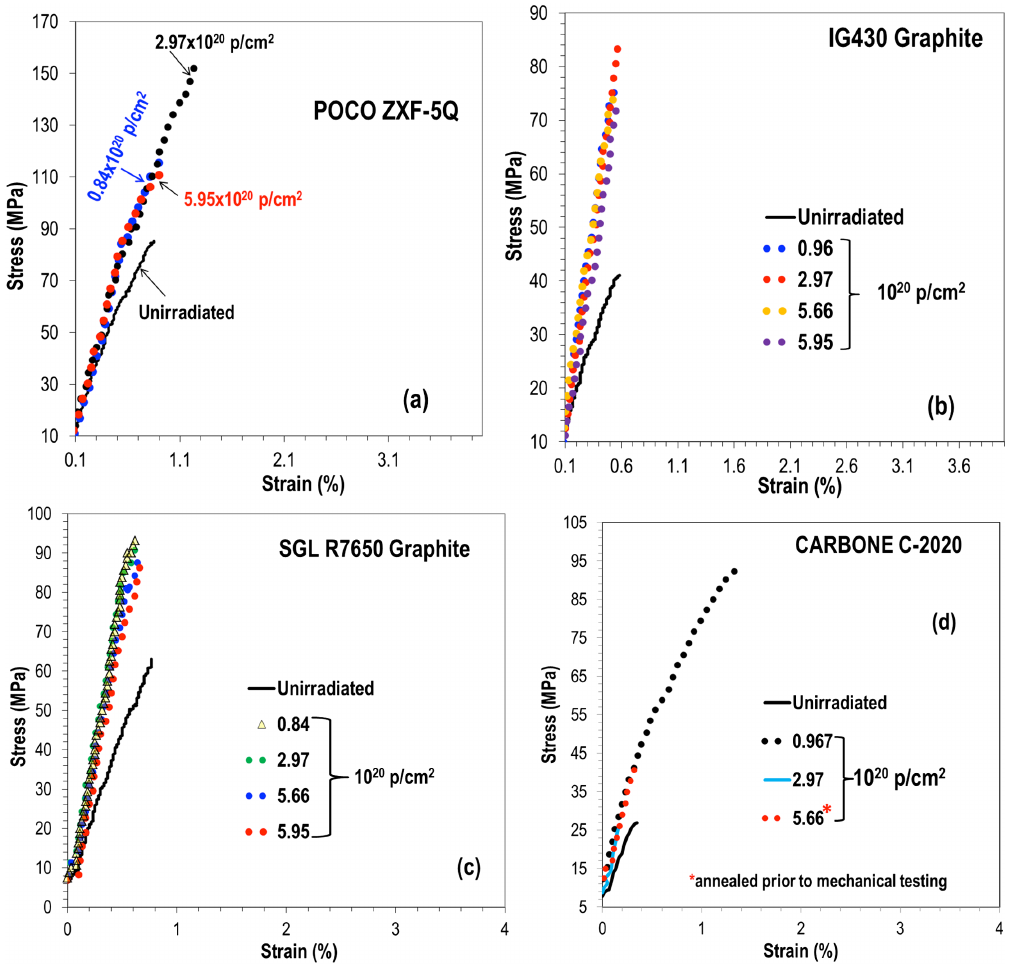
FIG. 12. Stress-strain behavior of proton irradiated (a) POCO, (b) IG 430, (c) SGL and (d) C-2020 graphite